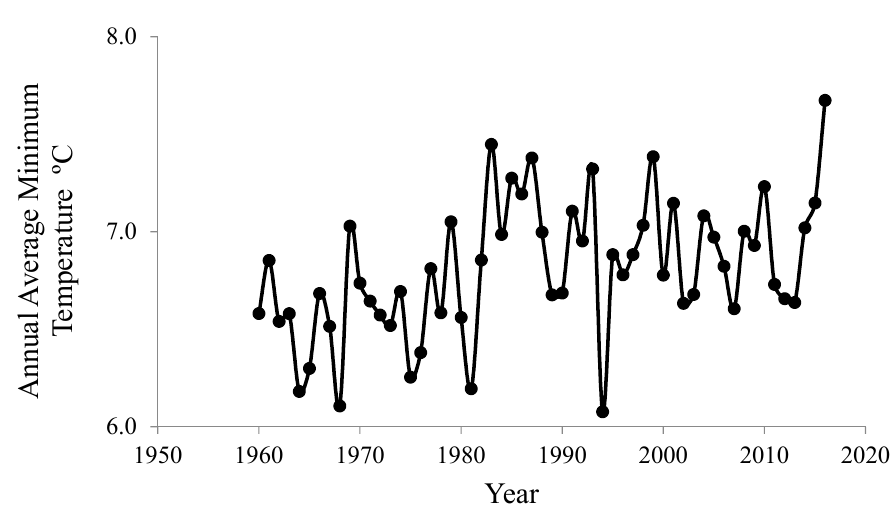
Figure 3. Annual average minimum temperature for the period 1960–2016.